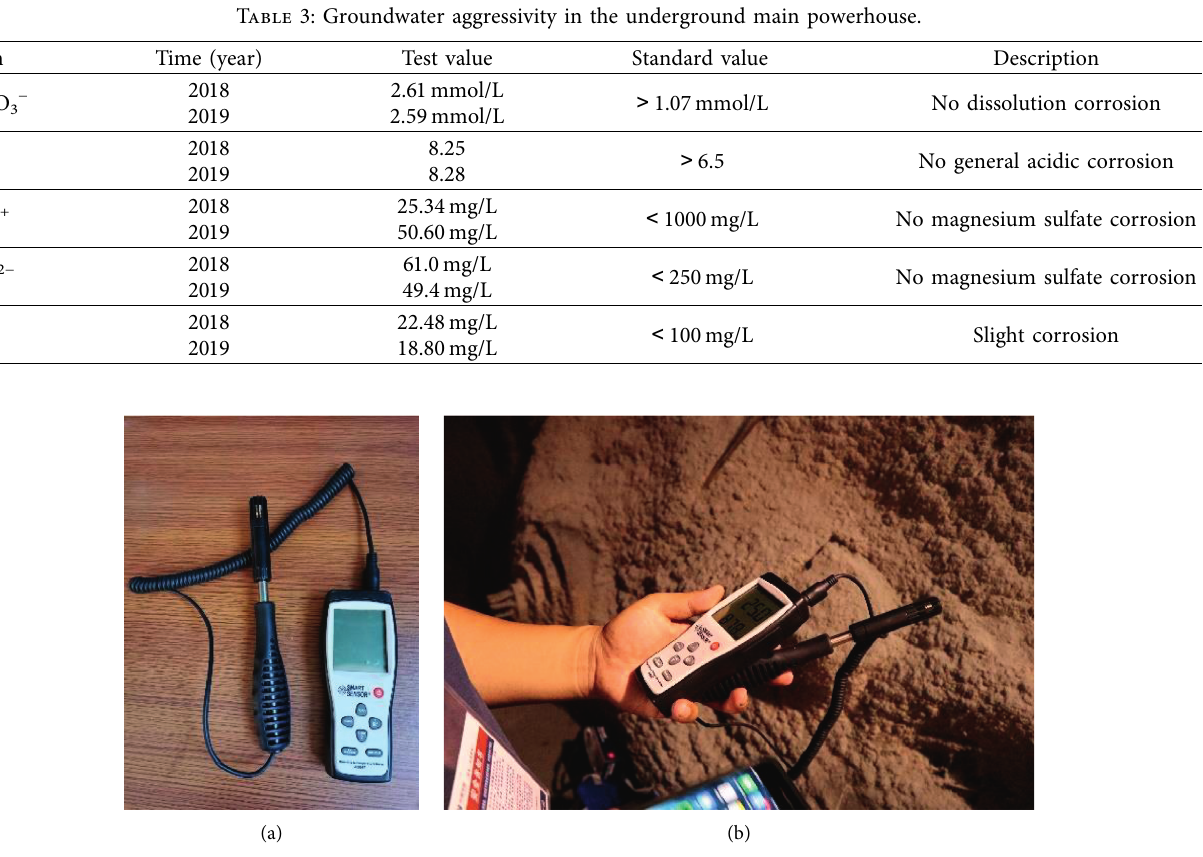
Figure 7: The Temperature and Humidity Measurement in the Tailrace Surge Chamber. (a) Humidity & temperature meter. (b) Field measurement. Table 4: Humidity & temperature in the tailrace surge